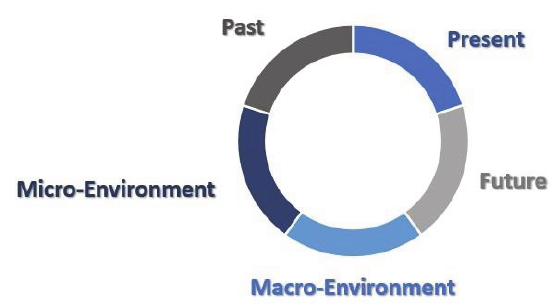
Figure 4. Elements of the end ‐ to ‐ end tool. Source: own